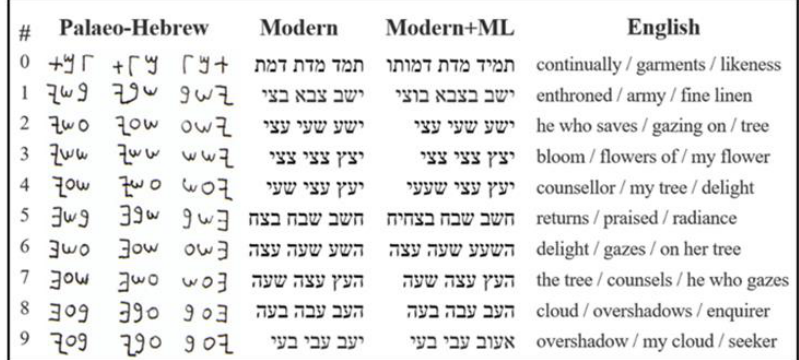
Figure 2. “Menorah” page from a Lead Book. Image (left) courtesy of Jean-Paul Bragard. Tracing (right) by Margaret Barker. See Supplementary Materials for more Figure 3. Reading the Menorah Page (see Figure 2 and text).